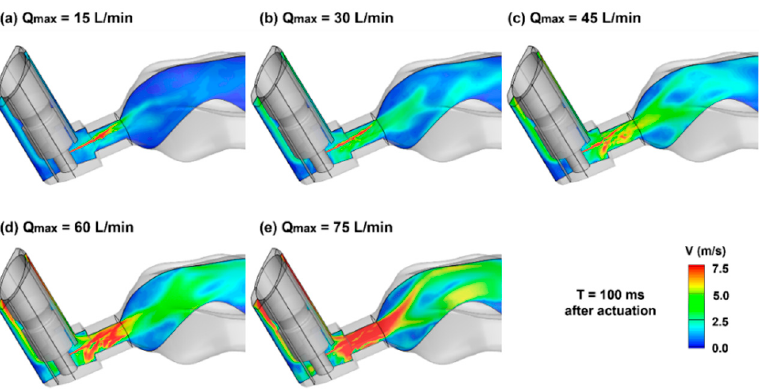
Figure 9. Mid-plane velocity contours at 100 ms after actuation with varying breathing depths (Q max ): ( a ) 15 L/min, ( b ) 30 L/min, ( c ) 45 L/min, ( d ) 60 L/min, and ( e ) 75 L/min.